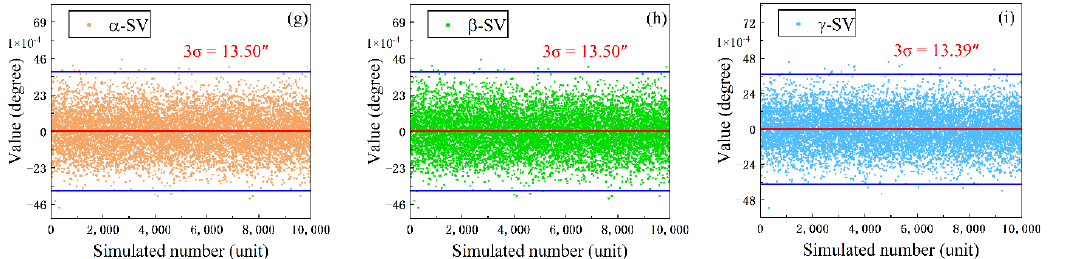
Figure 9. Distribution of rotation angle simulation values: ( a – c ) corresponds to (1); ( d – f ) corresponds to (2); and ( g – i ) corresponds to (3).